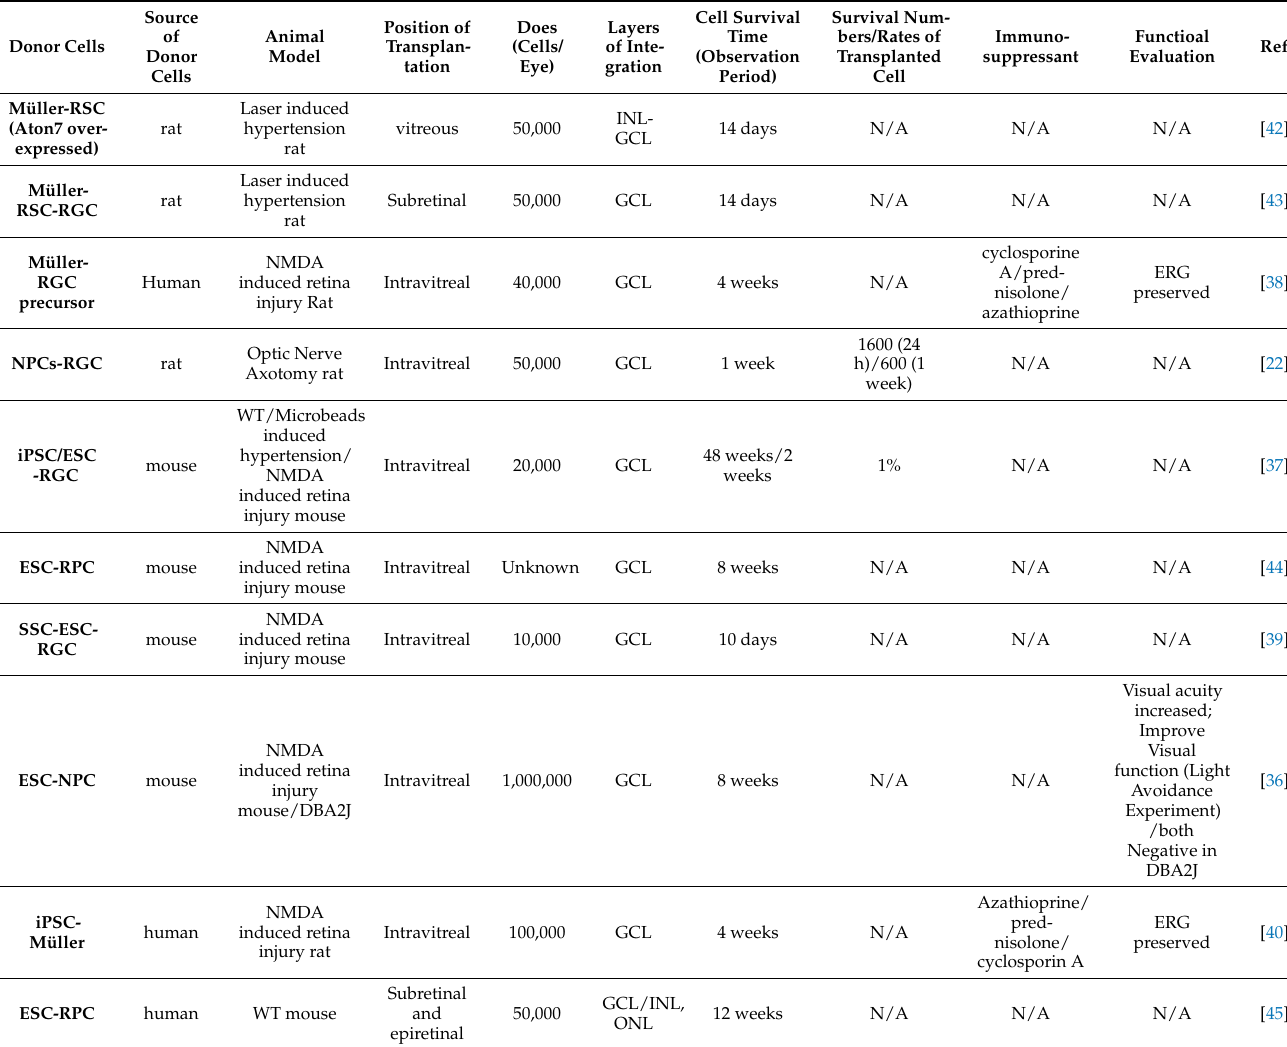
Table 1. Cell transplantation for RGC